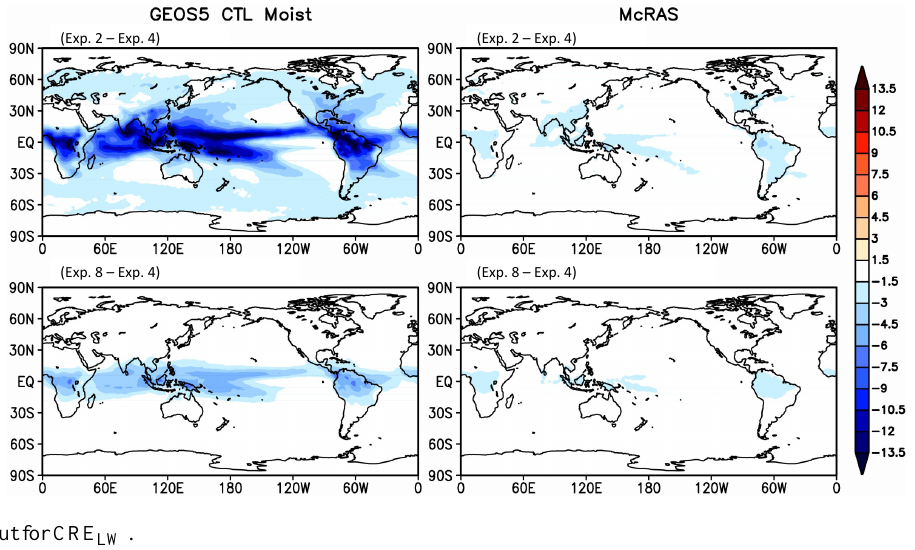
Fig. 6. As Fig. 5, but for CRE LW .